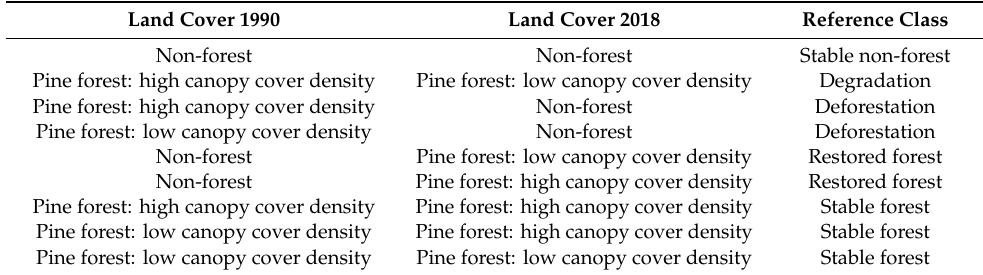
Table 3. The decision matrix for the validation samples interpreted from high-resolution images and a Landsat time series using Collect Earth (CE) and GEE, respectively.